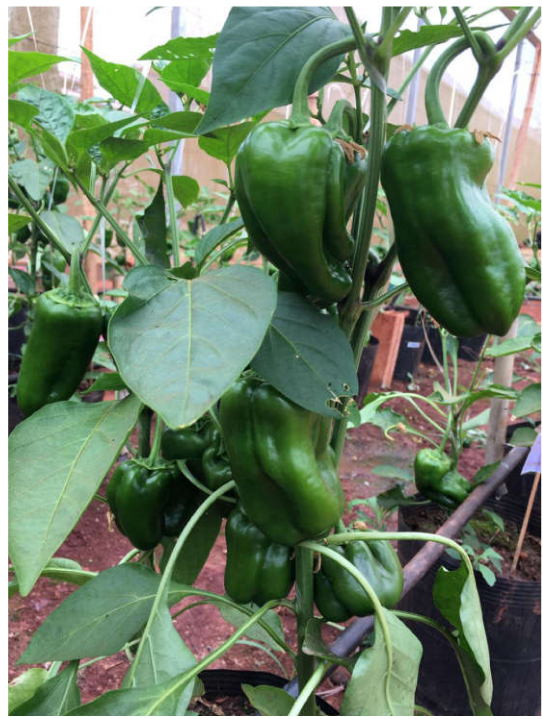
Figure 1. Pepper ( Capsicum annuum L.) with